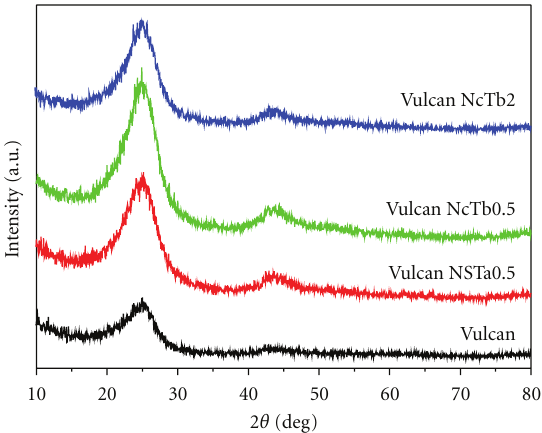
Figure 1: XRD patterns of carbon